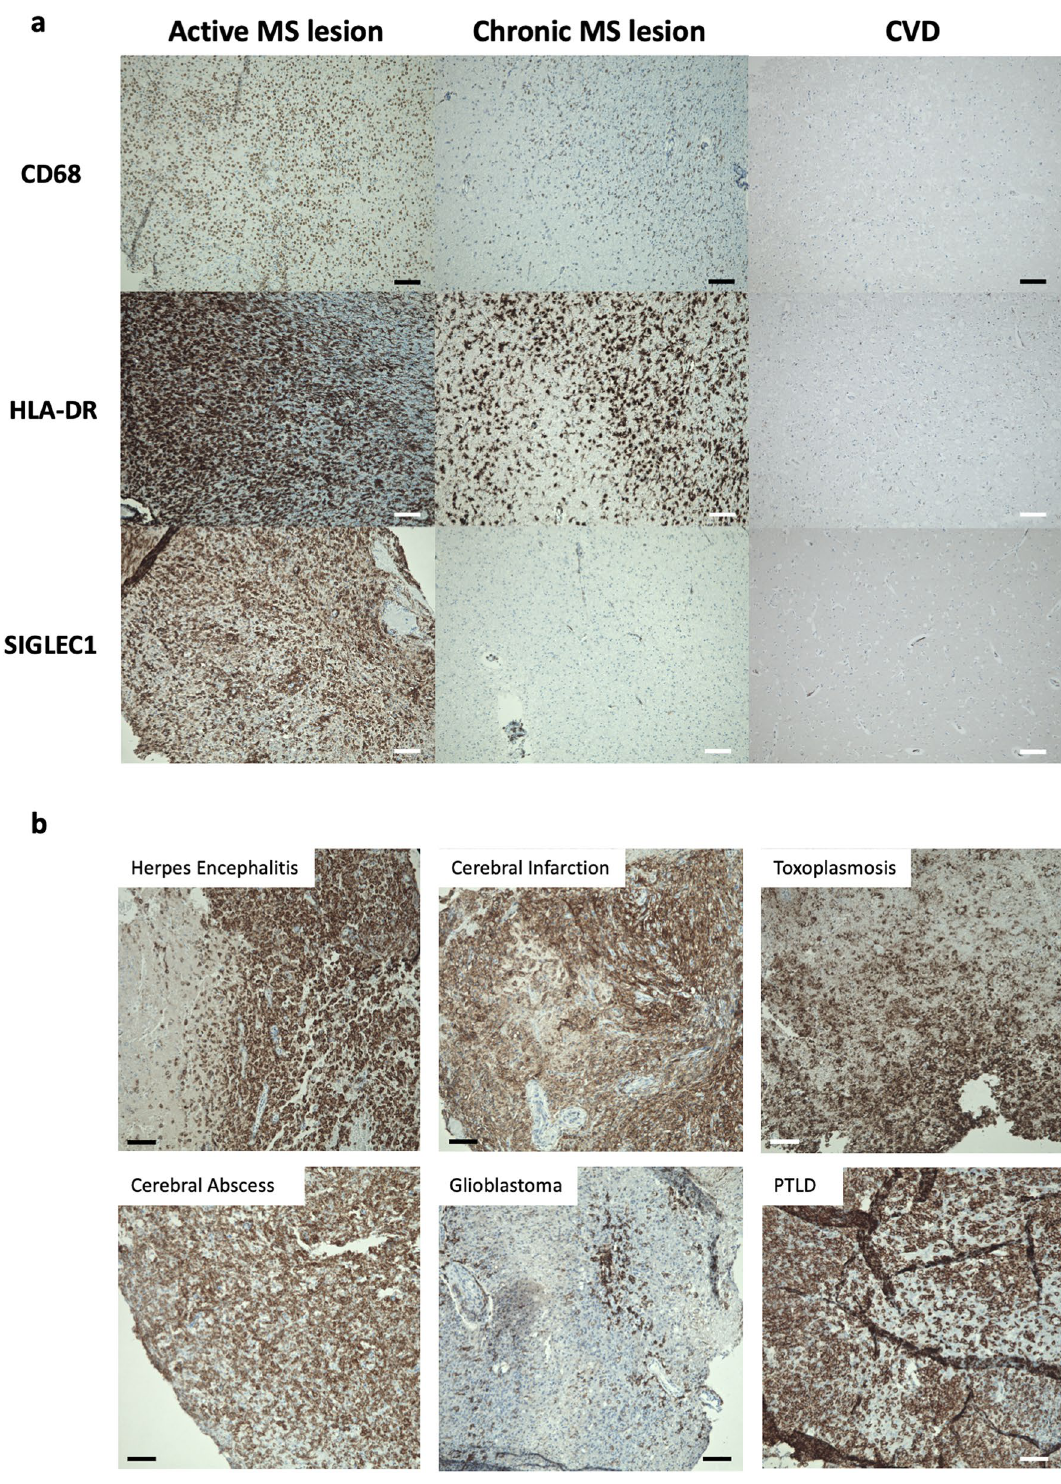
Figure 2. ( a ) Representative immunohistochemical stainings of CD68, HLA-DR and SIGLEC1 (CD169) in brain tissue from a patient with active inflammatory multiple sclerosis lesion, a chronic lesion from a patient with secondary-progressive multiple sclerosis (SPMS) and a control patient who died of cardiovascular disease (CVD). Both RRMS and SPMS show infiltrates with CD68 + and HLA-DR + myeloid cells, but only in the active lesion, these express SIGLEC1. Nuclei are stained blue and the respective marker antigens in brown. The scale bar indicates 100 µm. These results are representative of 4 RRMS, 5 SPMS and 7 control samples that were examined. ( b ) Immunohistochemical stainings of SIGLEC1 in brain tissue from patients with Herpes simplex viral encephalitis (n = 2), cerebral infarction with inflammatory changes (n = 2), cerebral toxoplasmosis (n = 1), cerebral abscess (n = 2), glioblastoma (n = 2) and post-transplant lymphoproliferative disease (PTLD, n = 1). Infiltrates of SIGLEC1 + myeloid cells were observed in all